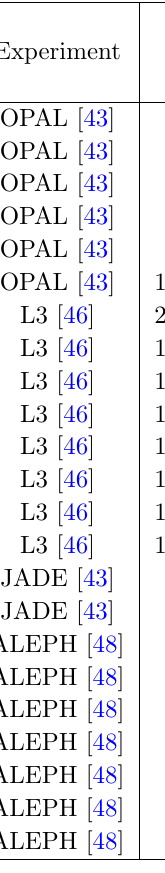
Table 1 . Data used for the determination of (cid:11) s in this work. The ranges of collision energies, their weighted average value (in brackets) and the number of events for each experiment are given as quoted in the original